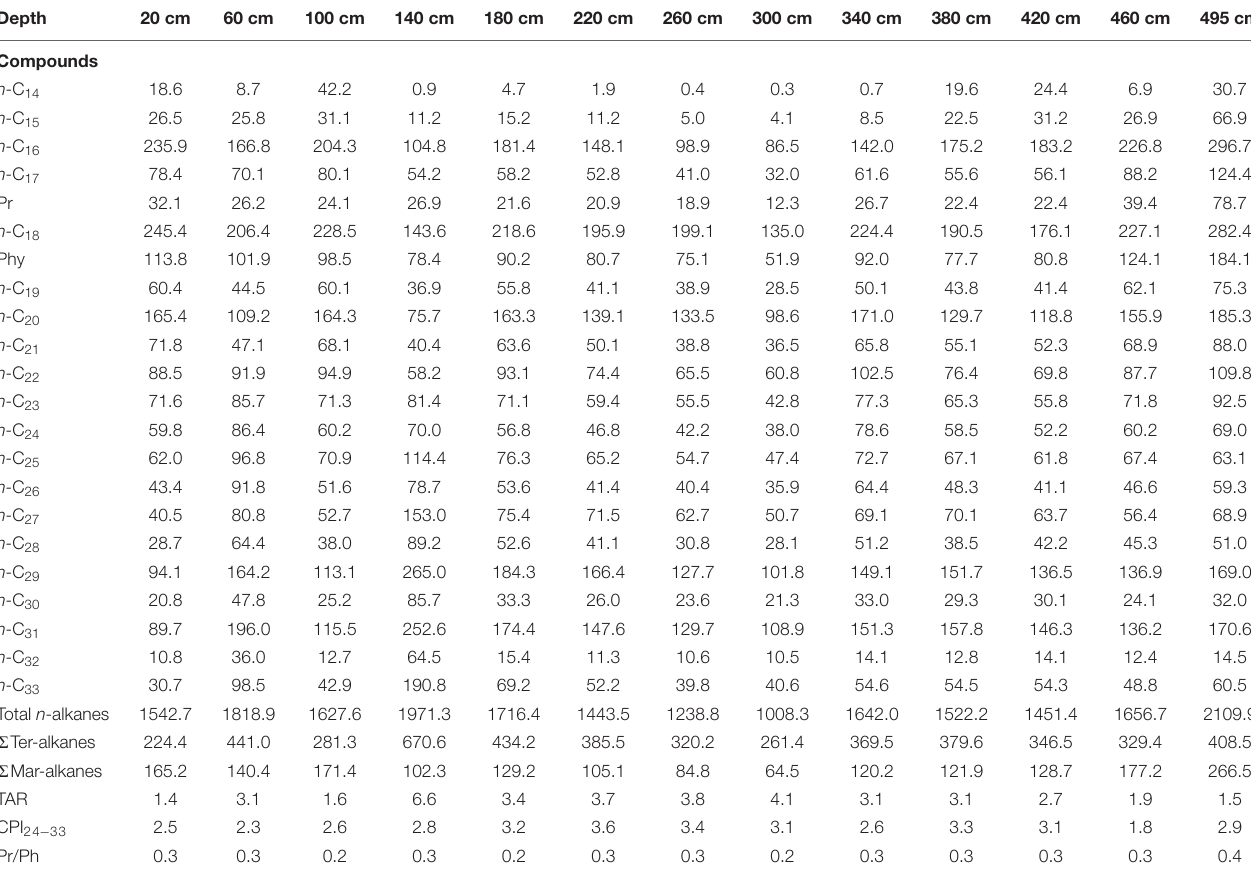
TABLE 3 | Concentration (ng/g sed.dry weight) of hydrocarbon in B station of the Southwest Sub-basin. Depth 20